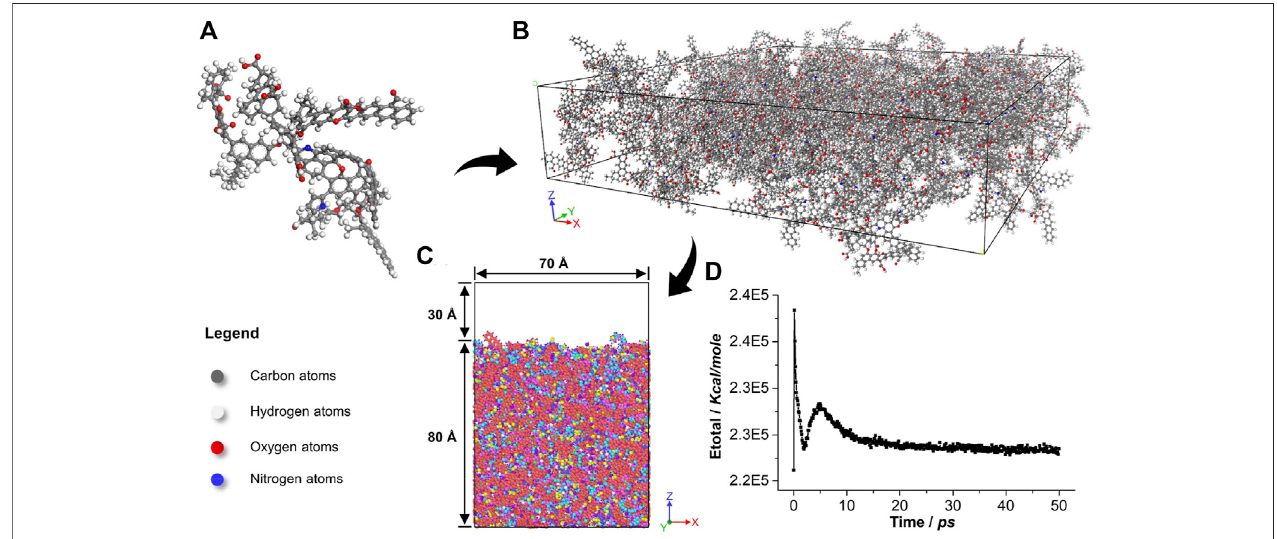
FIGURE1| Construction oflayered vitrinite con fi guration using Materials Studio 8.0: (A) singlevitrinite unit, (B) vitrinitecon fi guration composed of100single units, (C) optimized vitrinite con fi guration with30 Åvacuum space(atoms are shown colored byPCFF force fi eld type). (D) Total energy ofthe vitrinite con fi guration during the optimization process.